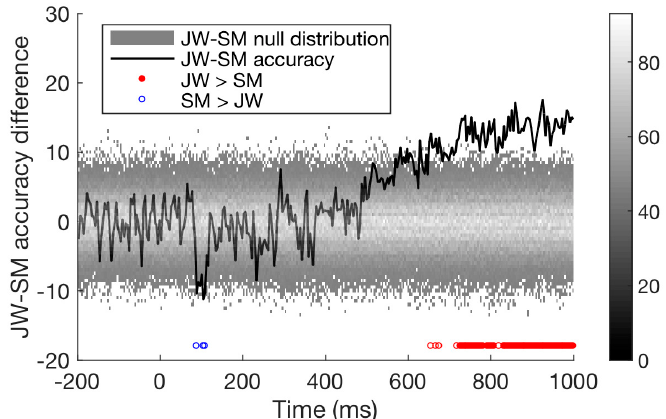
Figure 6. Difference in time course classification results for the two visual agnosia patients (JW minus SM). Accuracy for the two agnosia patients differed over time; around 100 ms, SM outperformed JW, but from 500 ms onwards JW had much higher decoding accuracy than SM, p < 0.01. Vision 2018 , 2 , x FOR PEER REVIEW